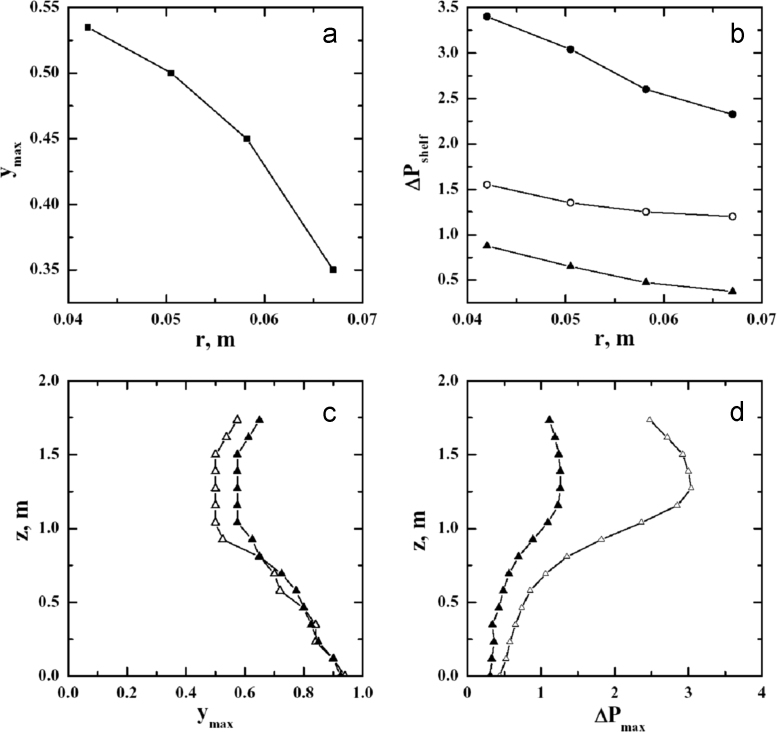
Influence of the clearance, r, on the location of maximum pressure, ymax, for the shelves at the level of the duct (a), and on ΔPmax, for three different shelves, numbered from bottom (b): ▲, third shelf; ○, sixth shelf; ●, shelf close to the duct. On the lower graphs, the variation of ymax (c) and ΔPmax (d), with the z-coordinate for the L3 configurations at two different sublimation fluxes: Δ, 1 kg h−1 m−2; ▲, 0.5 kg h−1 m−2.